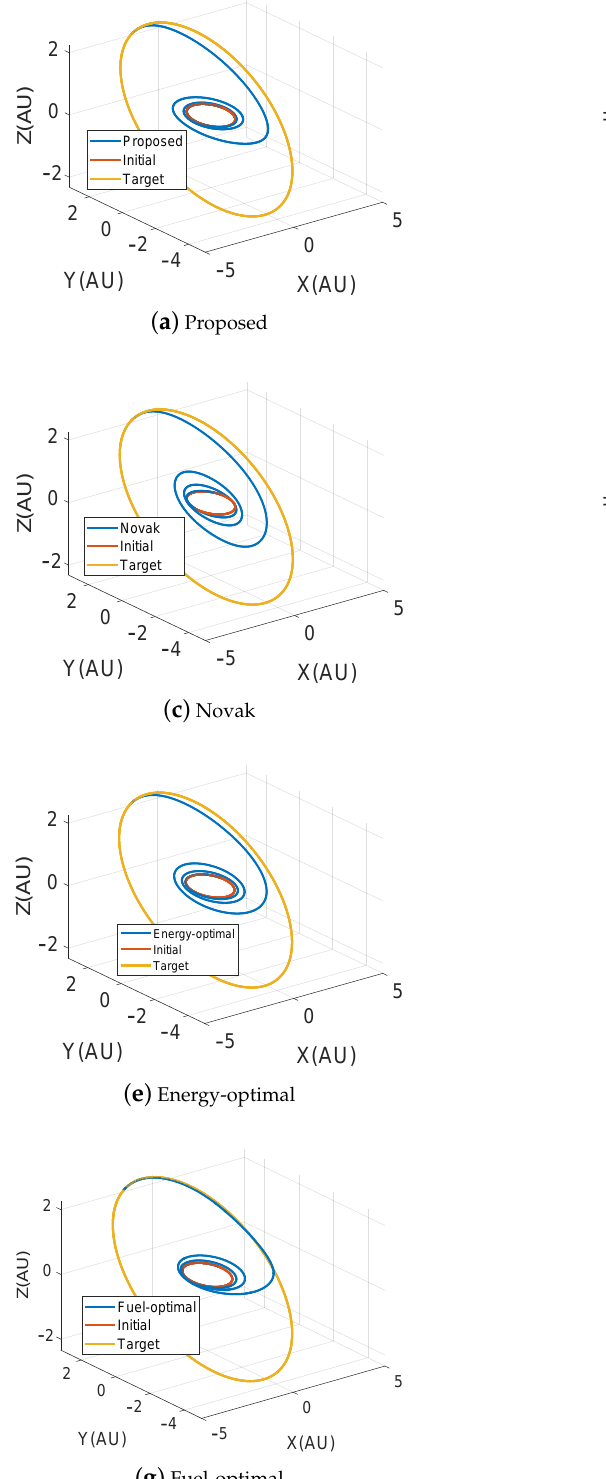
Figure 8. Rendezvous result of three